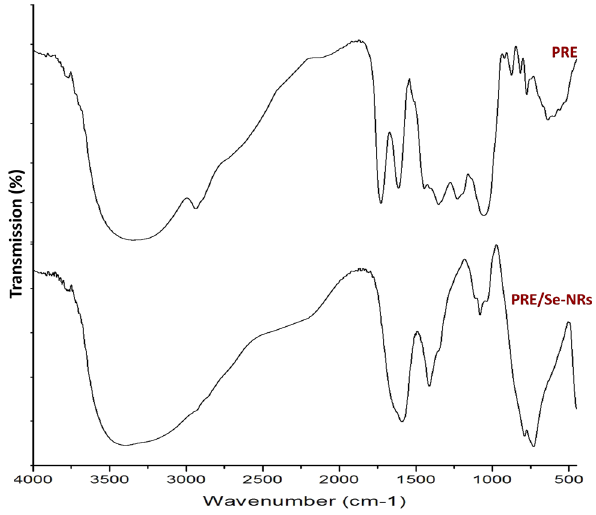
Figure 2: FTIR patterns for the extract of pomegranate rinds ( PRE ) and phytosynthesized Se - Nanorods with the extract ( PRE/Se - NRs ) .